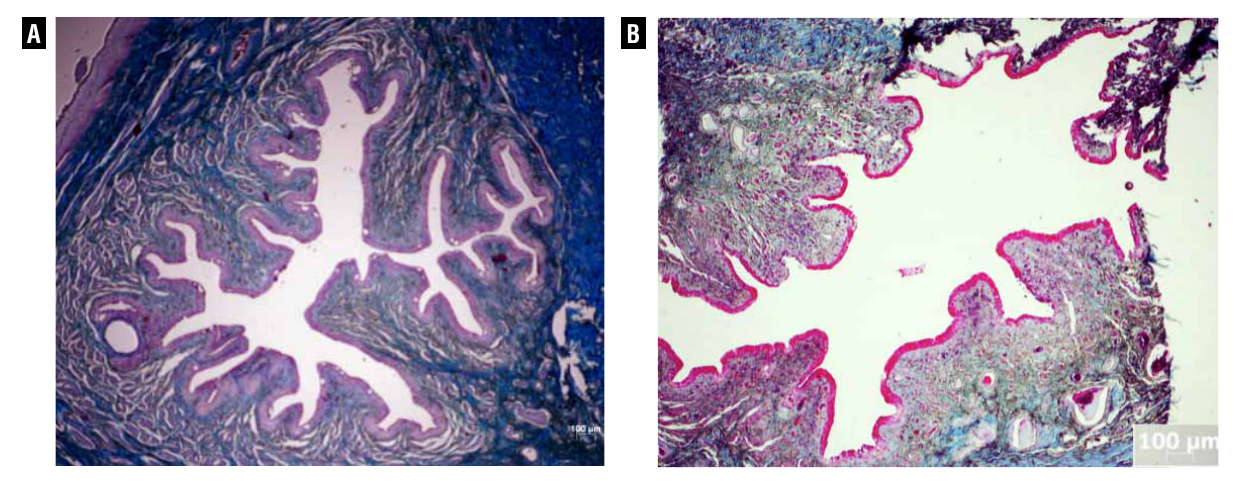
Figure 6 - A - Photomicrography of the urethra - Group I animal, postoperative day 90, Masson’s trichrome, 25x. B - Photo- micrography of the urethra - Group II animal, postoperative day 90, Masson’s trichrome,